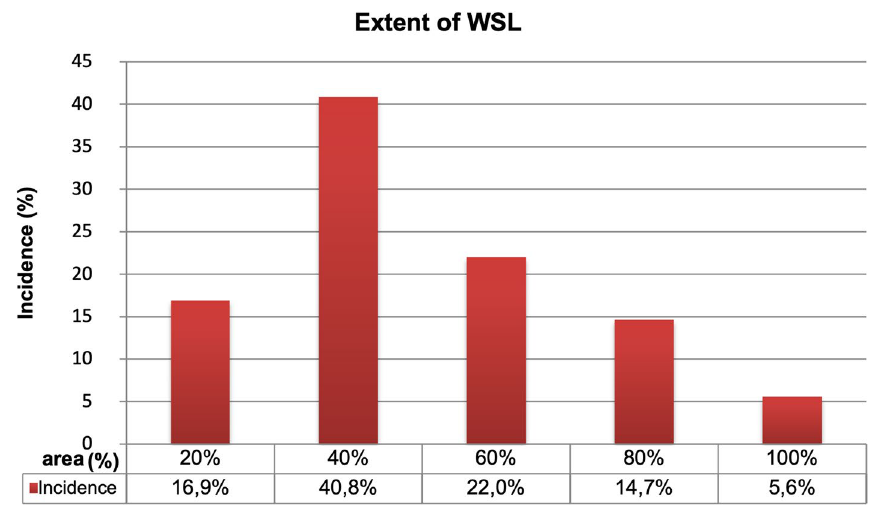
Figure 7. Distribution of the incidence according to extent